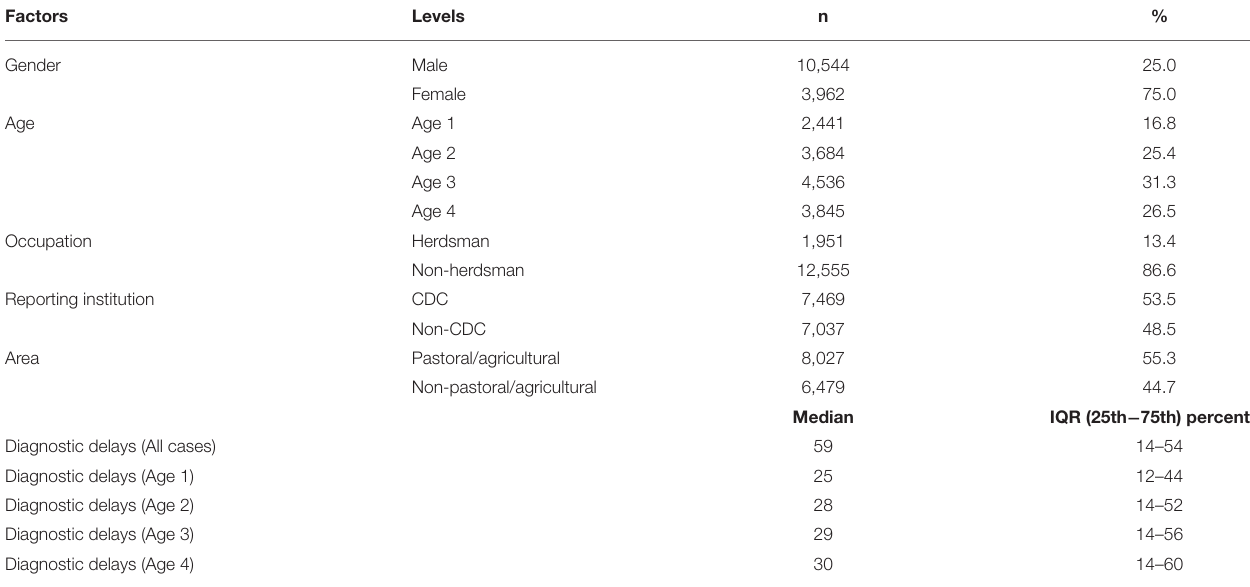
TABLE 1 | The characteristics of patients with human brucellosis (HB) ( N = 14,506).